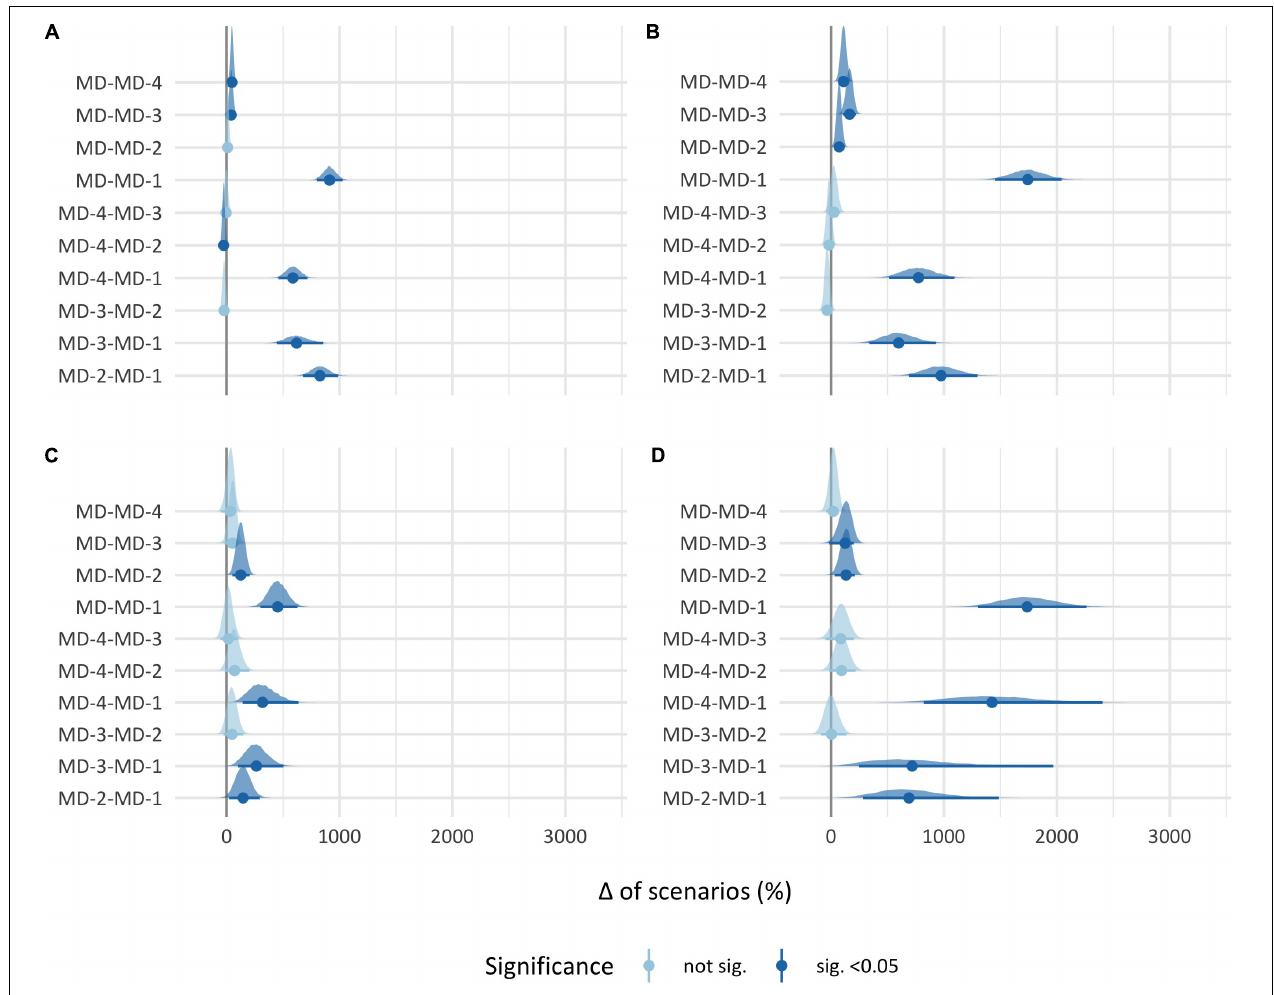
FIGURE 3 | 95% Confidence interval difference of number of high-demanding scenarios between match days. Each point represents the mean difference, and each black line through the point represents the 95% confidence interval of the difference between the two match days. (A) Total distance. (B) Player load. (C) High-intensity accelerations. (D) High-intensity